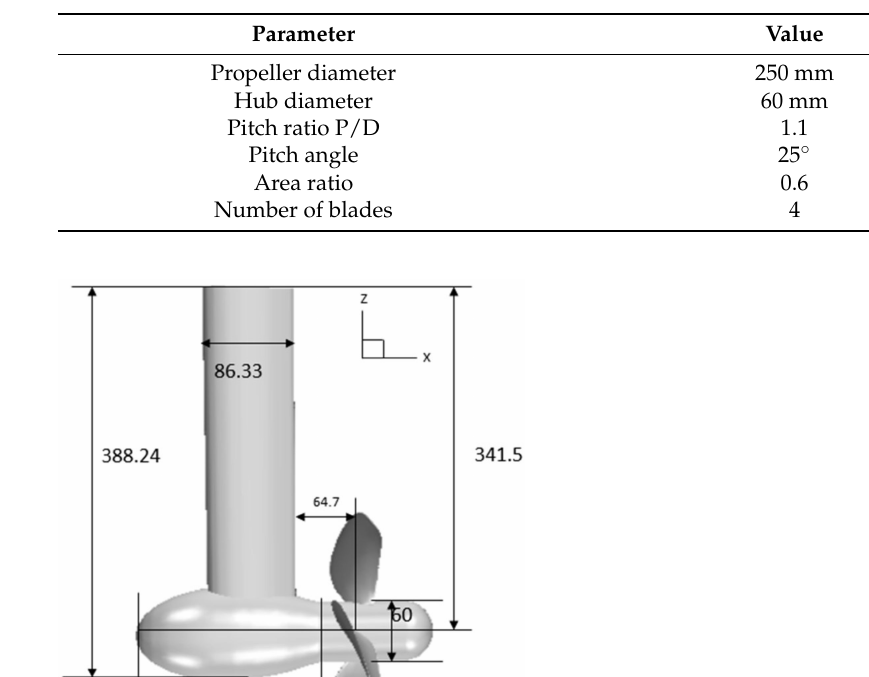
Table 1. Main parameters of the propeller.